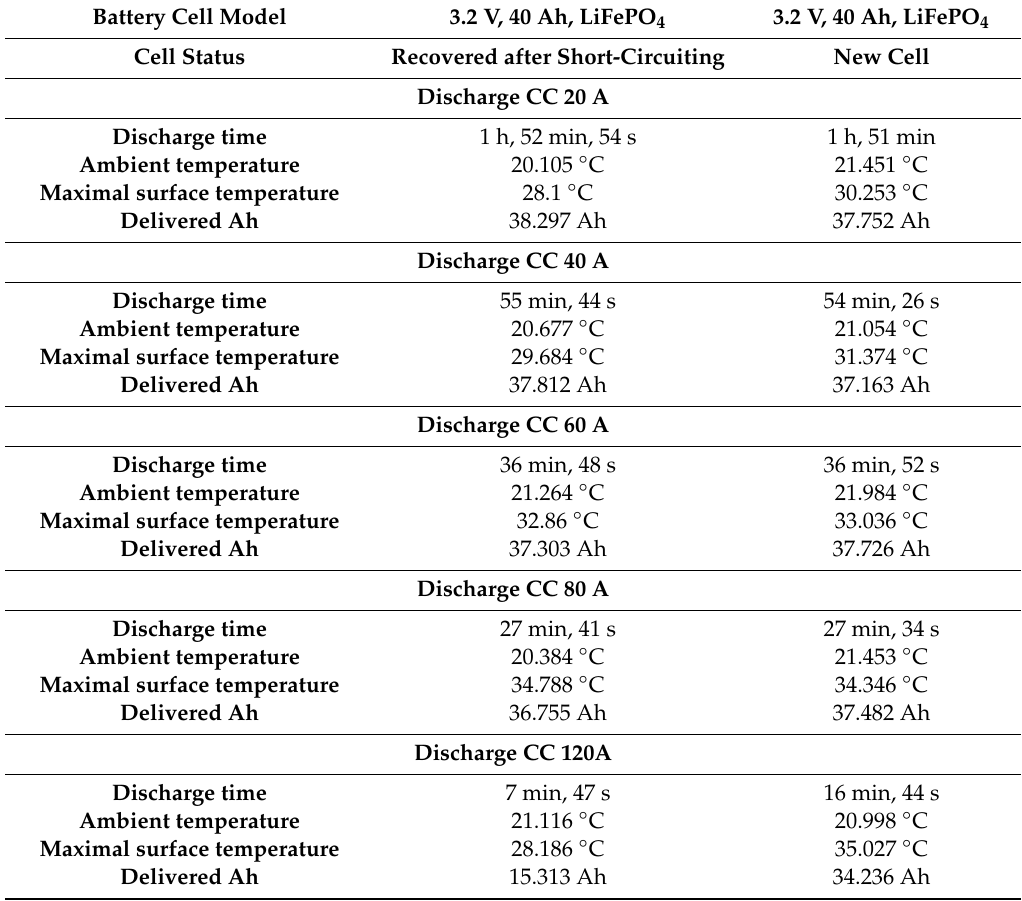
Table 5. Summary of the results of the verification test of short-circuited